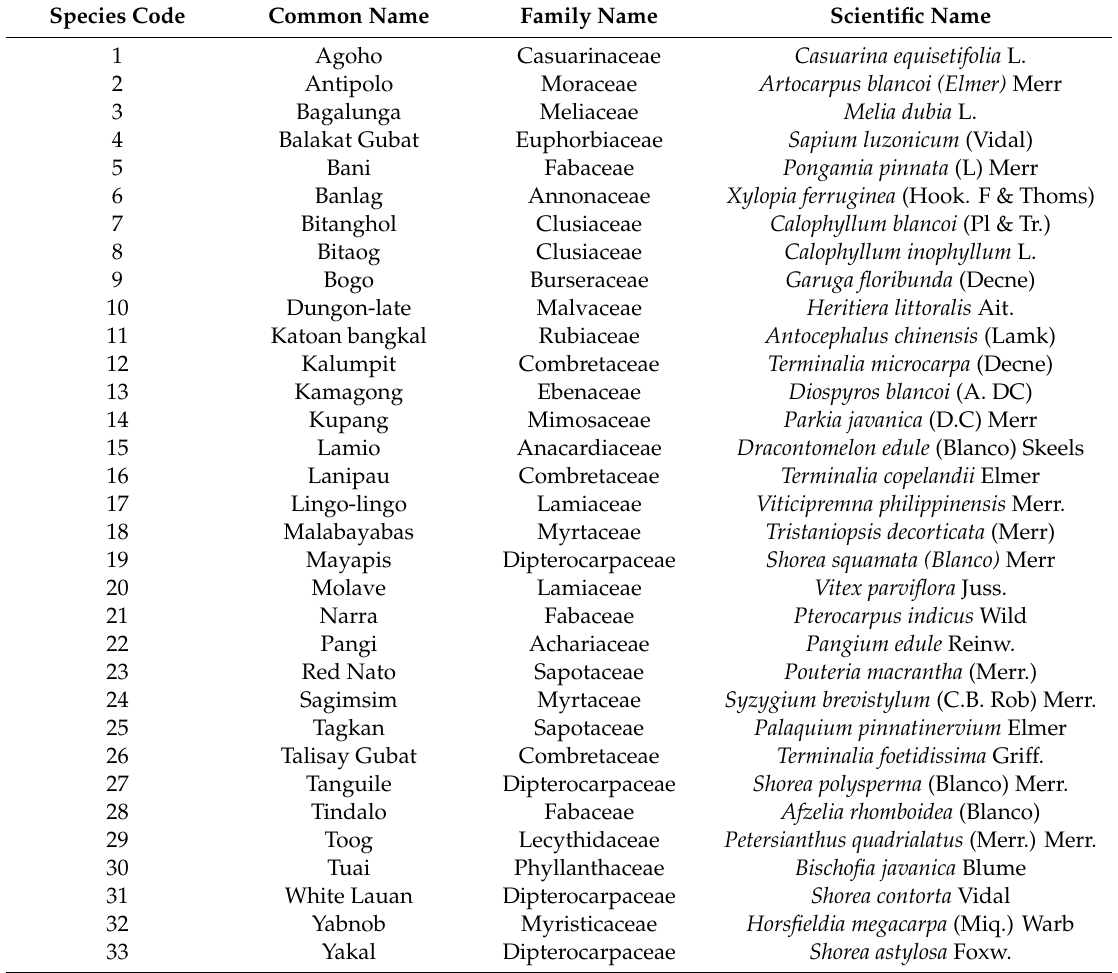
Table 1. Native species considered for tree domestication